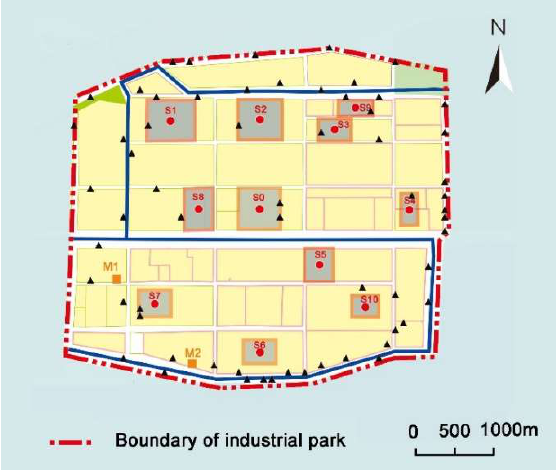
Figure 8. The spatial distribution of the optimal AQMN with 64 monitors. Orange squares indicate two existing monitors, and black triangles indicate added monitors in the optimal scheme.